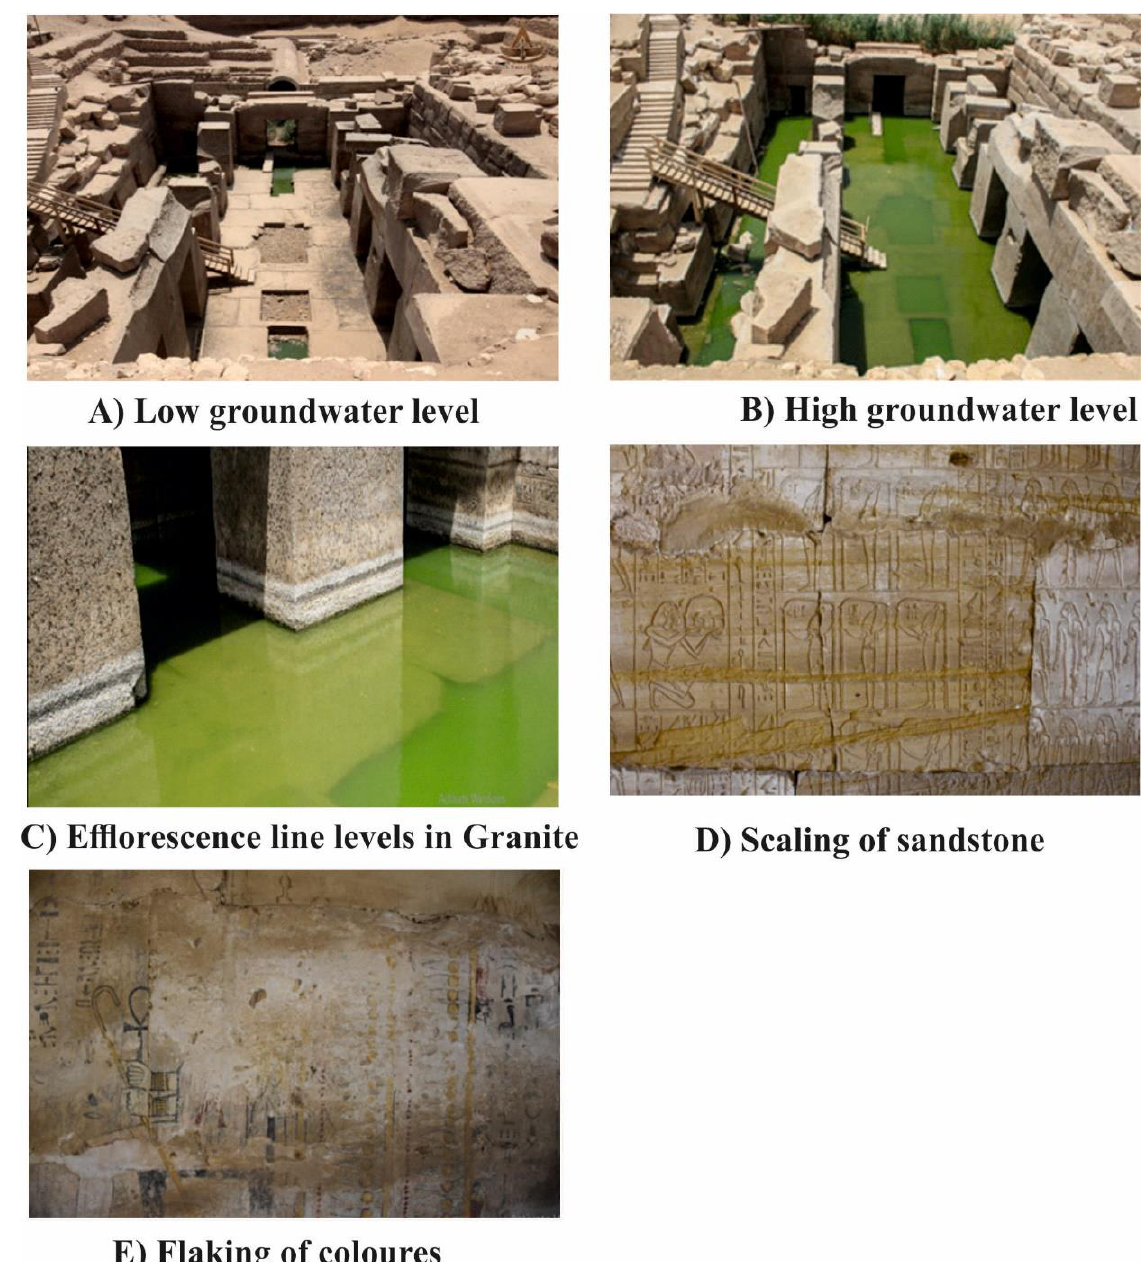
Figure 2. Showing the effects of the groundwater at the Osirion site, where ( A ) indicates the decreasing of the groundwater level in summer season; ( B ) shows the increasing of the groundwater rising in winter season; ( C ) shows the efflorescence line levels in granite pillars; ( D ) indicates the deterioration of historic symbols and colors on stone surfaces; and ( E ) indicates the destruction of wall paintings at the Abydos Temple.